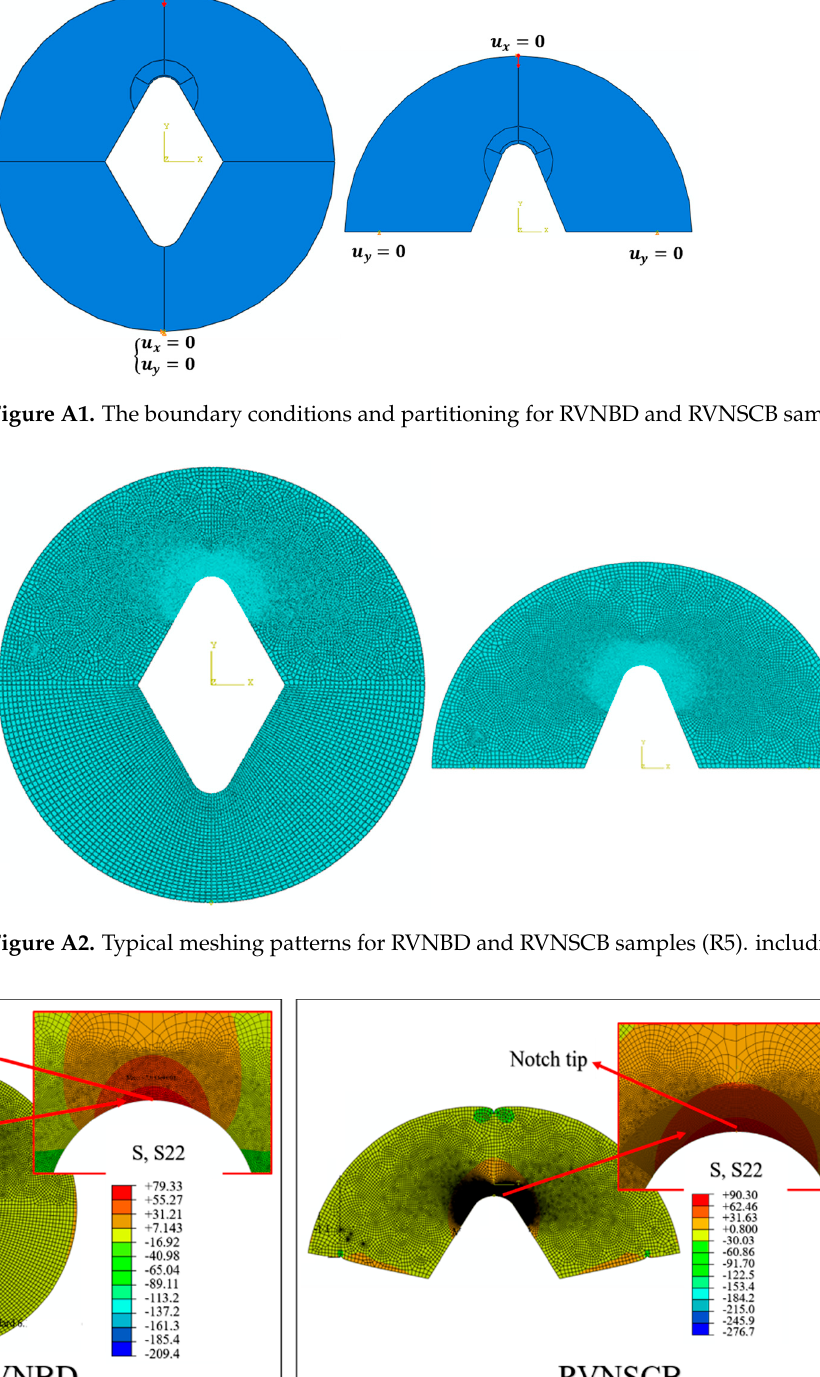
Figure A3. The tangential stress contour around the notch border for RVNBD and RVNSCB specimens of R35.